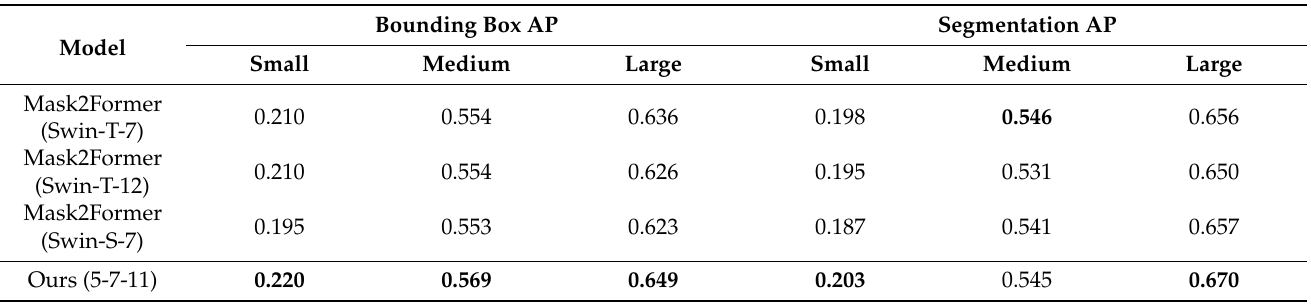
Table 2. Results of case segmentation at different scales. Our improved network achieves good results at all scales. The maximum improvement is reflected in the Bounding Box AP Small, up 1.5 percentage points.